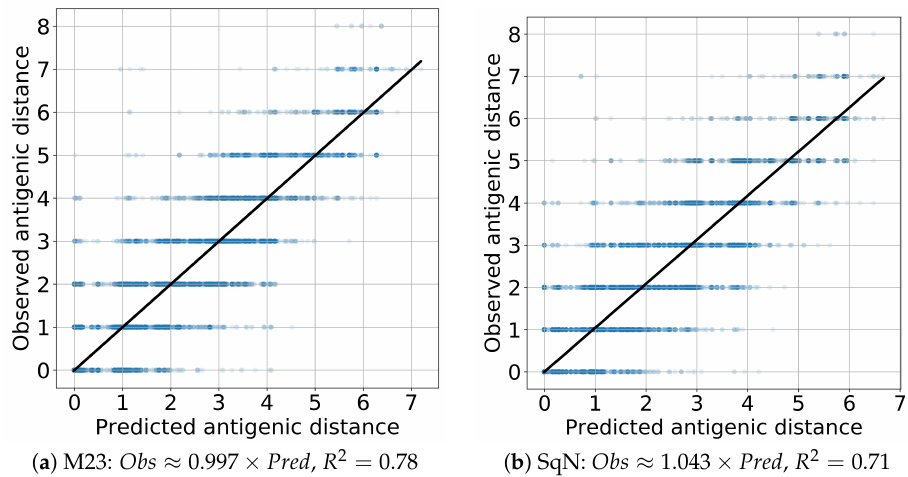
Figure 14. Titer: linear